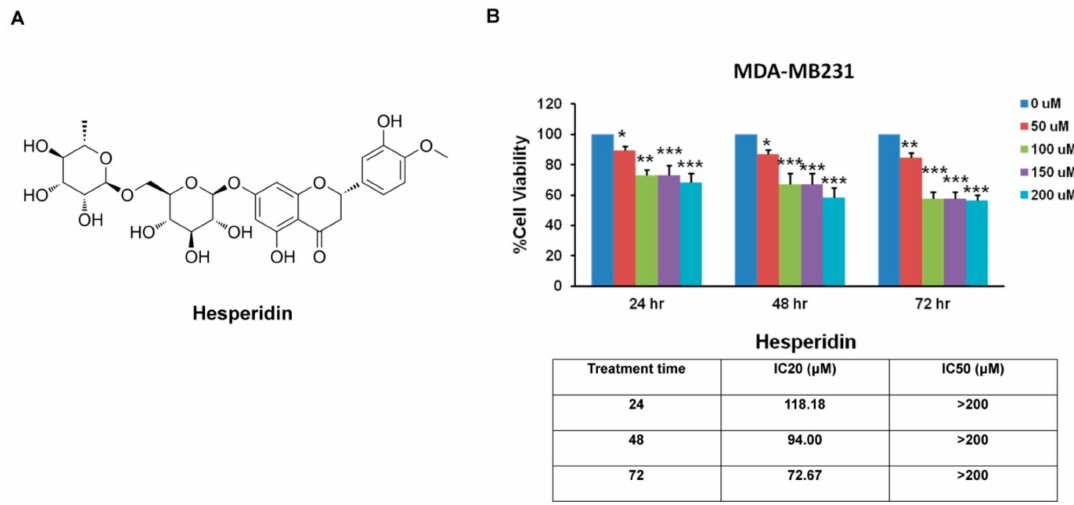
Figure 2. The cytotoxic e ff ect of hesperidin assessed by MTT assay. ( A ) Chemical structure of hesperidin and ( B ) shows the percentage of cell viability of MDA-MB231 breast cancer cells, grown in the presence of hesperidin (0 to 200 µ M) at 24, 48, and 72 h. All data are presented as mean ± SD from three or more independent experiments. Statistical significance * p < 0.05, ** p < 0.01, and *** p < 0.001 versus the control at equal incubation